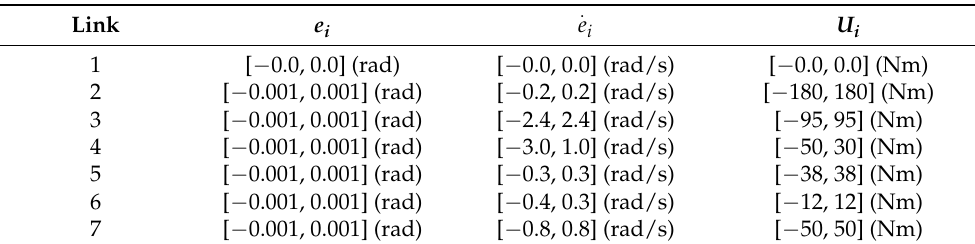
Table 4. The physical value domain of input and output quantities of the bipedal robot’s fuzzy